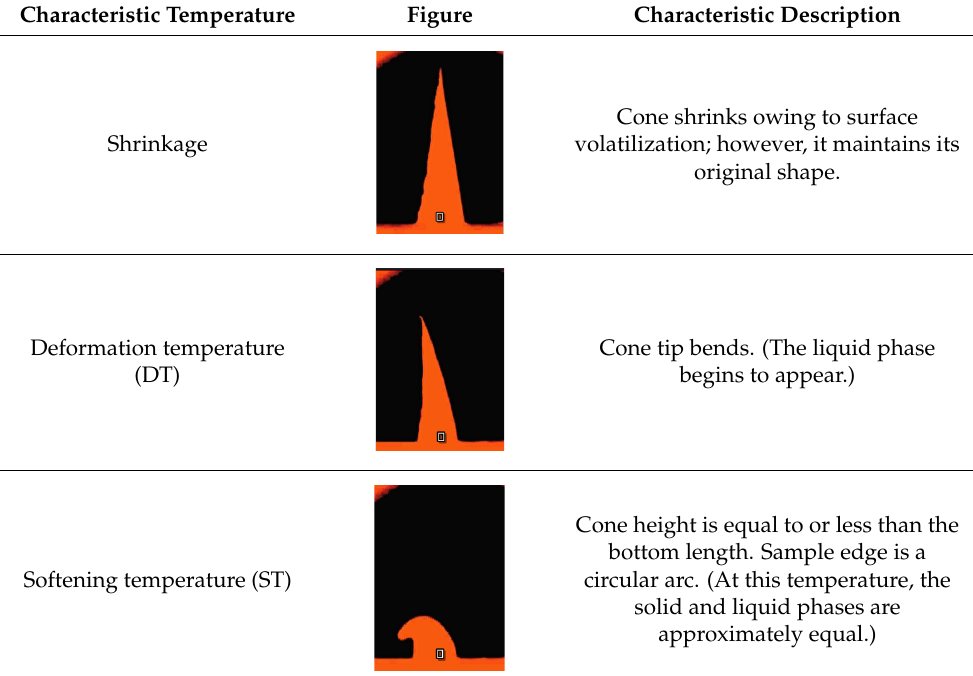
Table 3. Sample fusibility analysis (insert figure: characteristic points at different temperatures). Characteristic Temperature Figure Characteristic Description